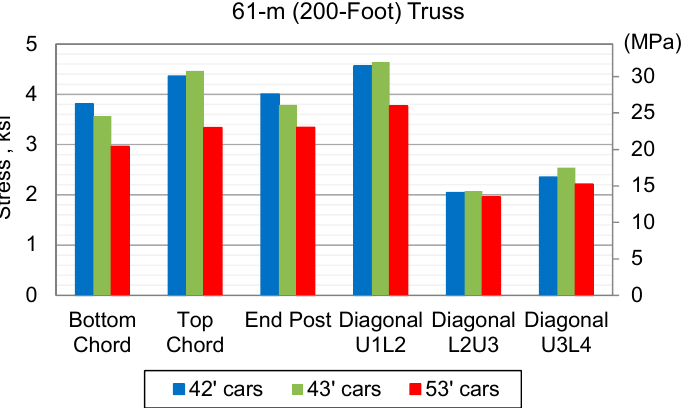
Figure 11. Typical peak stress calculated from measured strains, comparison for 61 ‐ m (200 ‐ ft) span. The top and bottom chords experienced stress increases of 31 and 28%, respectively.